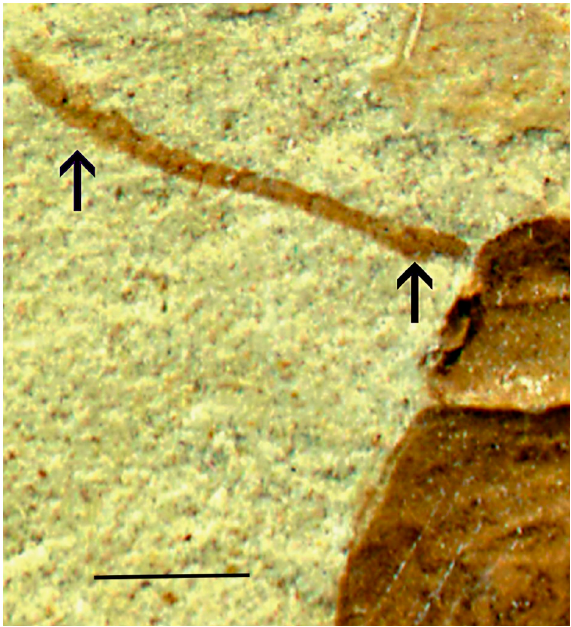
Figure 3. Apoclion antennatus Chang, Kirejtshuk & Ren, holotype. Antenna with subapically attached antennomere 2 (right arrow) and three enlarged apical antennomeres (left arrow). Scale 1 mm.